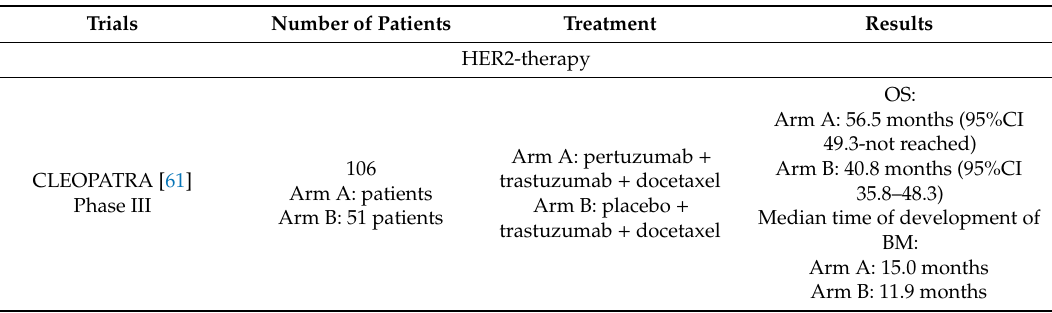
Table 1. Clinical Trials on BM in Breast